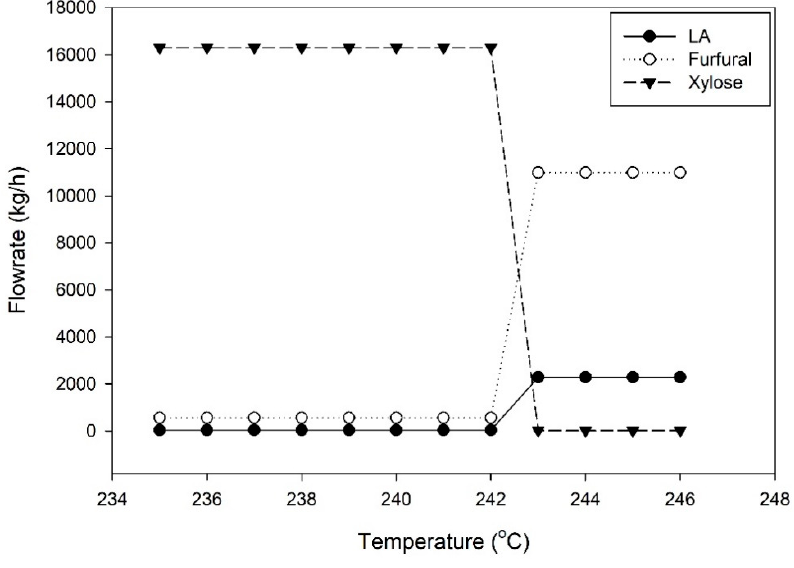
Figure 3. Component flowrates versus reaction temperature in the furfural reactor.